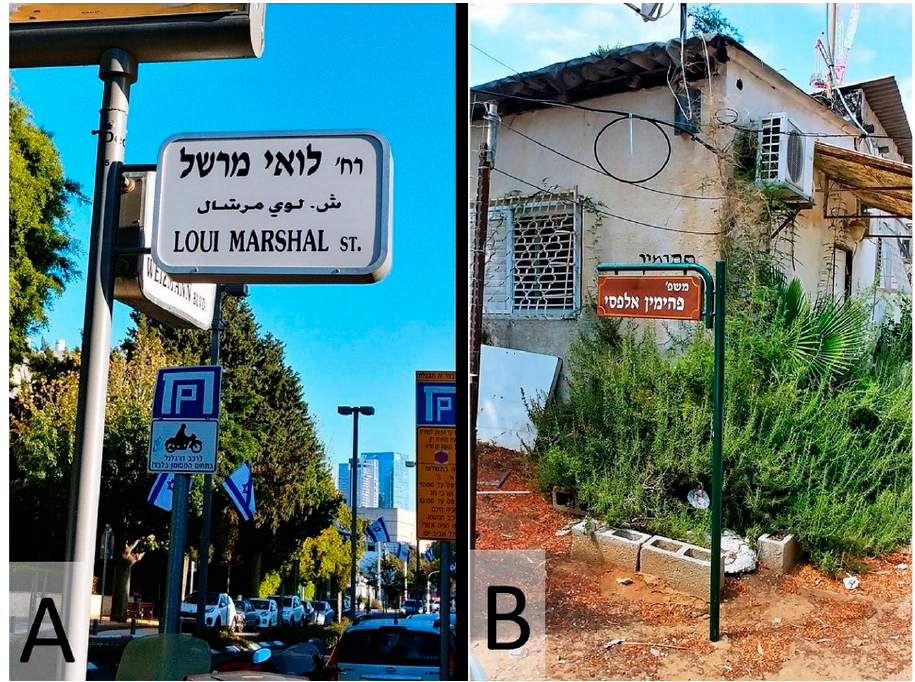
Figure 1. ( A ) An “indexed” street signage in Tel Aviv ( B ) self-initiated signage in an extra-formal quarter in Tel Aviv, designed after a family name (author’s photos).